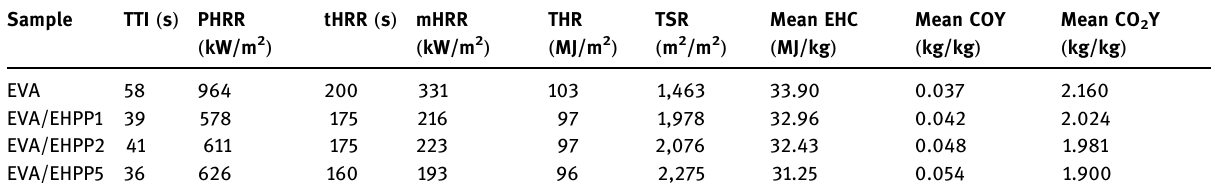
Table 4: Cone calorimeter data of EVA and its composites